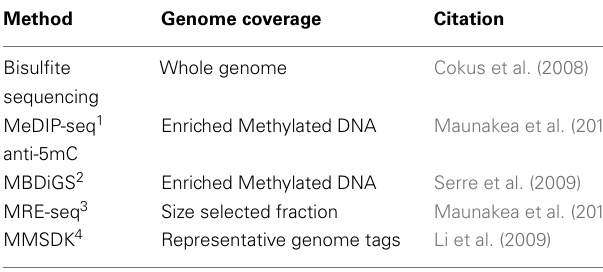
Table 5 |Approaches for DNA methylation analyses by next-generation